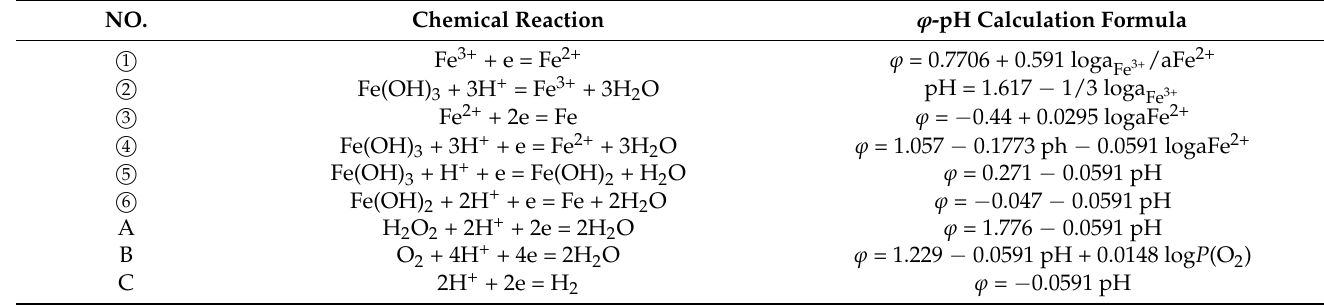
Table 1. Chemical reactions in solution (under normal temperature and pressure).